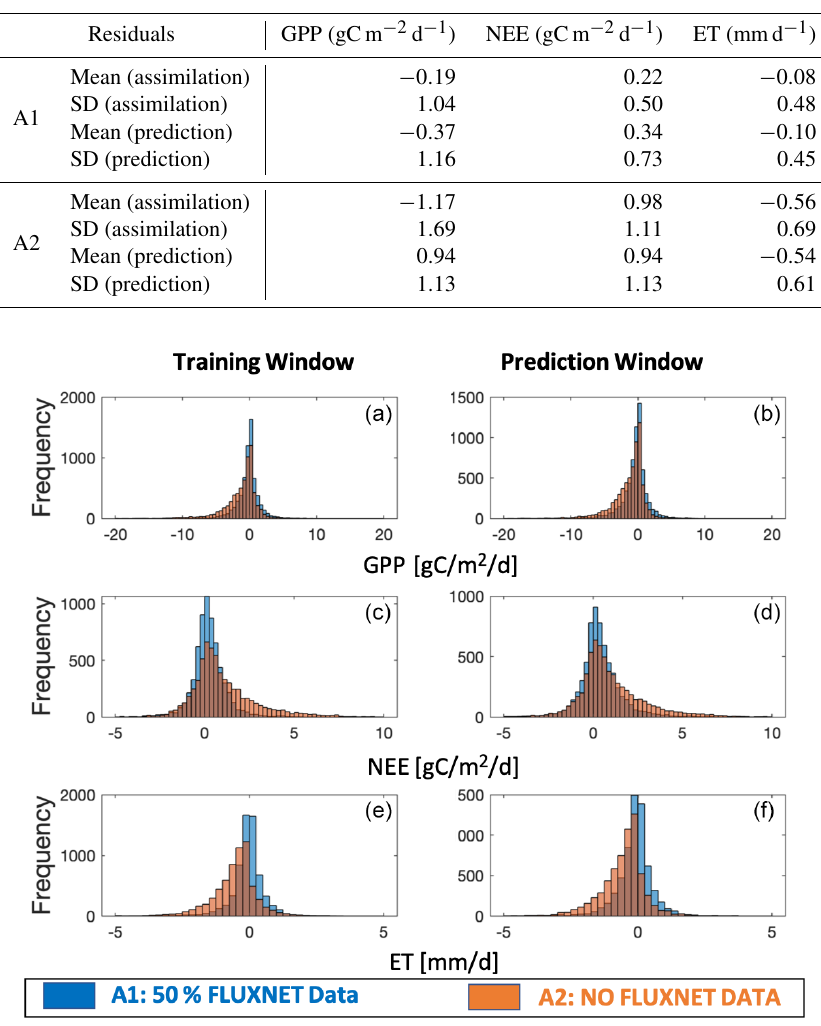
Figure 3. Histogram of monthly-based residuals over all sites for the assimilation window (a, c, e) and prediction window (b, d, f) . Residuals are the differences between model outputs (GPP, NEE, and ET) and observations (GPP, NEE, and ET measured at tower sites). Two different CARDAMOM runs are shown as A1 and A2 (A1 means model simulations using 50% FLUXNET data as constraints; A2 means baseline model simulations with no FLUXNET